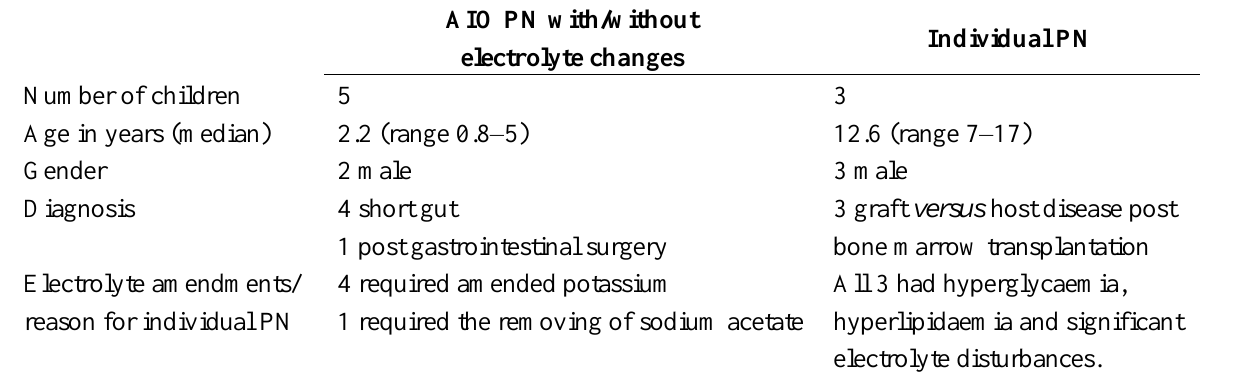
Table 3. Patient